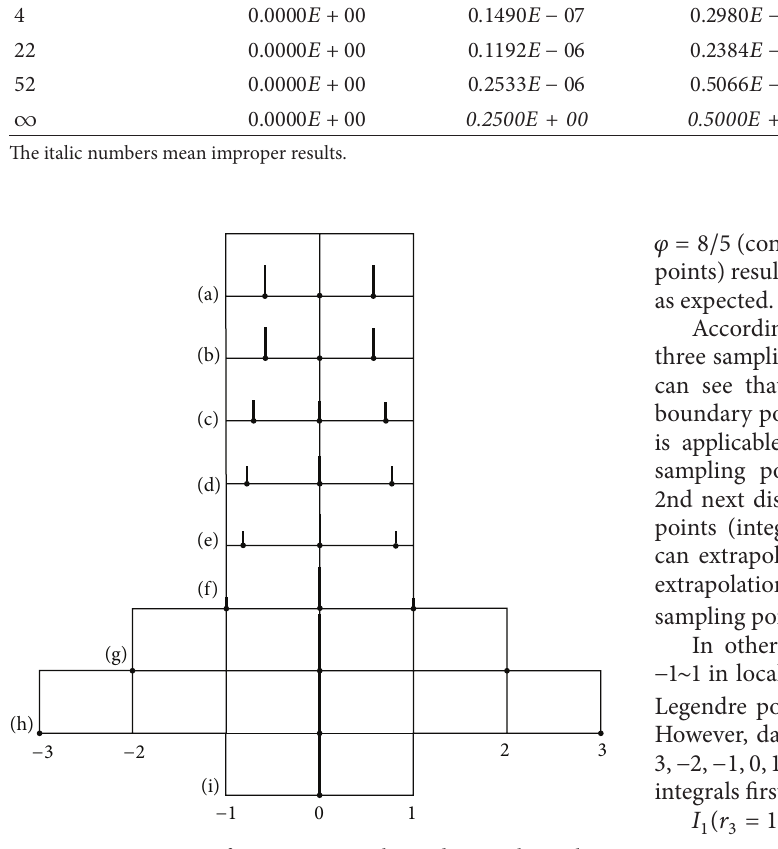
Figure 1: Various sets of integration weights and optimal sampling points with respect to the weight ratio 𝜑 ; (a) 𝜑 = 0 , (b) 𝜑 = 𝜀 , (c) 𝜑 = 1 , (d) 𝜑 = 8/5 , (e) 𝜑 = 2 , (f) 𝜑 = 4 , (g) 𝜑 = 22 , (h) 𝜑 = 52 , and (i) 𝜑 = ∞